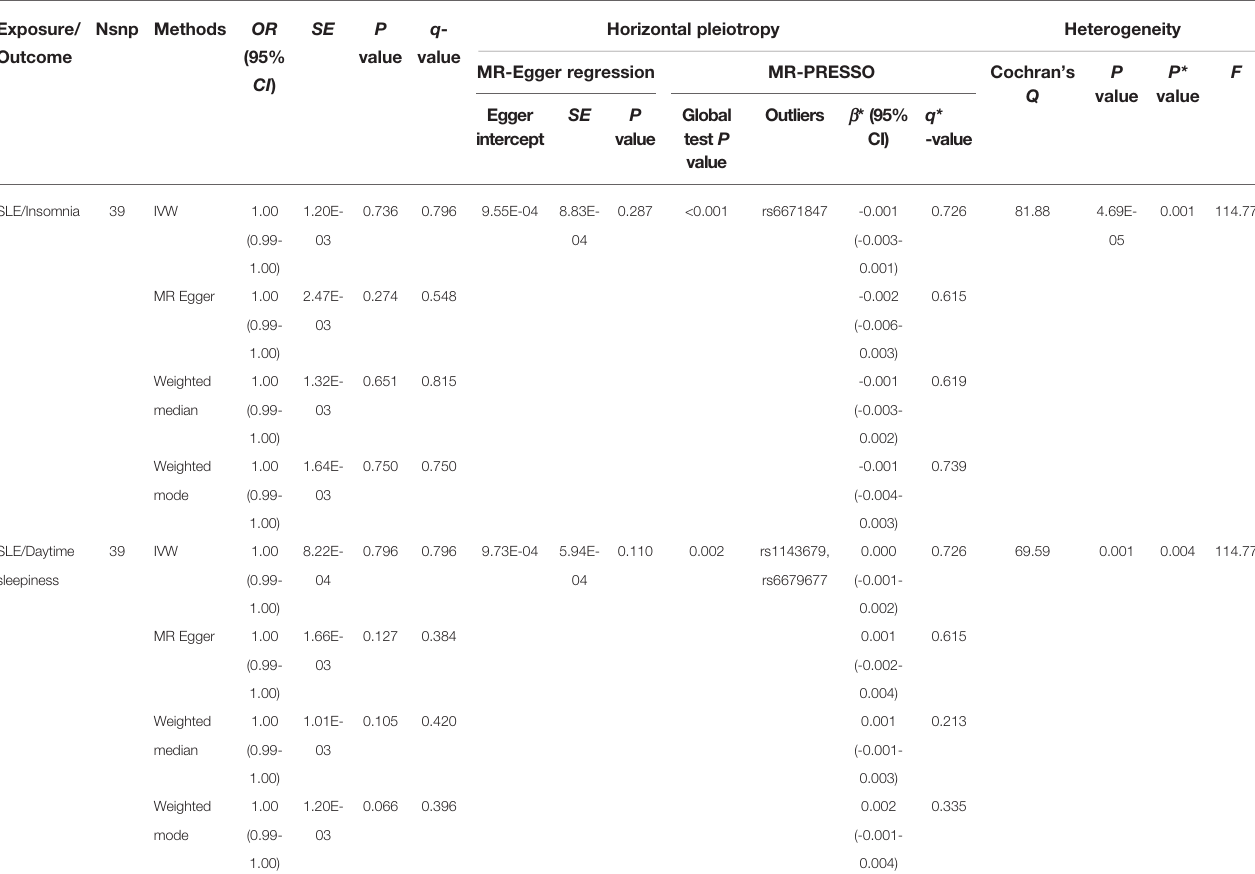
*The result of recalculation after removing outliers. MR-PRESSO, MR-Pleiotropy Residual Sum and Outlier method. OR, odds ratio; CI, con fi dence interval; IVW, inverse-variance weighted. q-value, P-value corrected for False Discovery